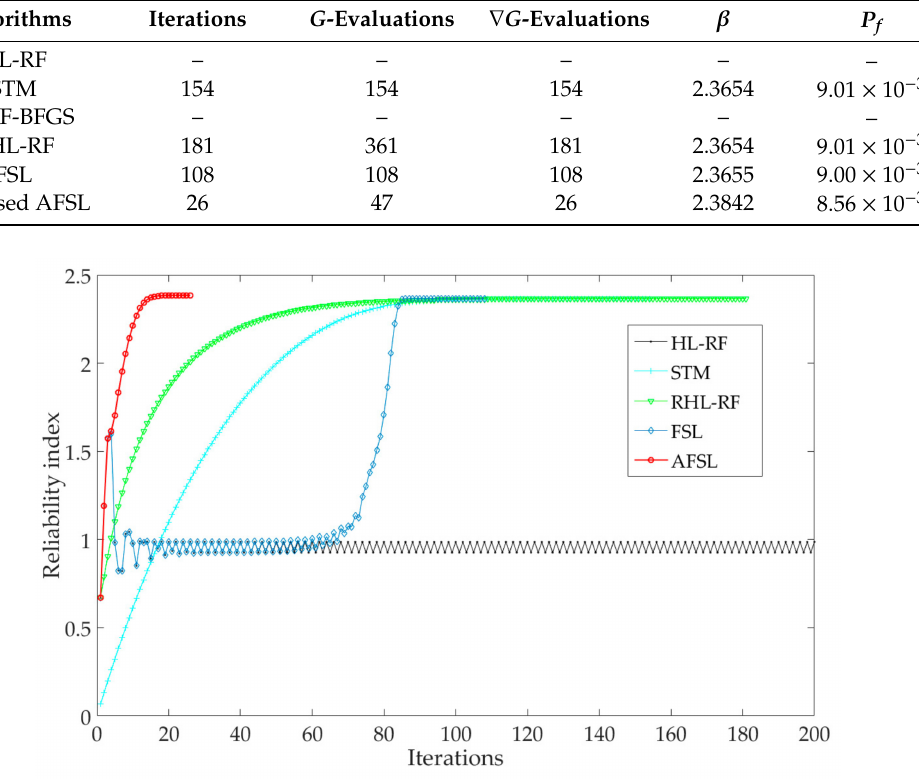
Figure 4. Iterative processes of reliability index for Example